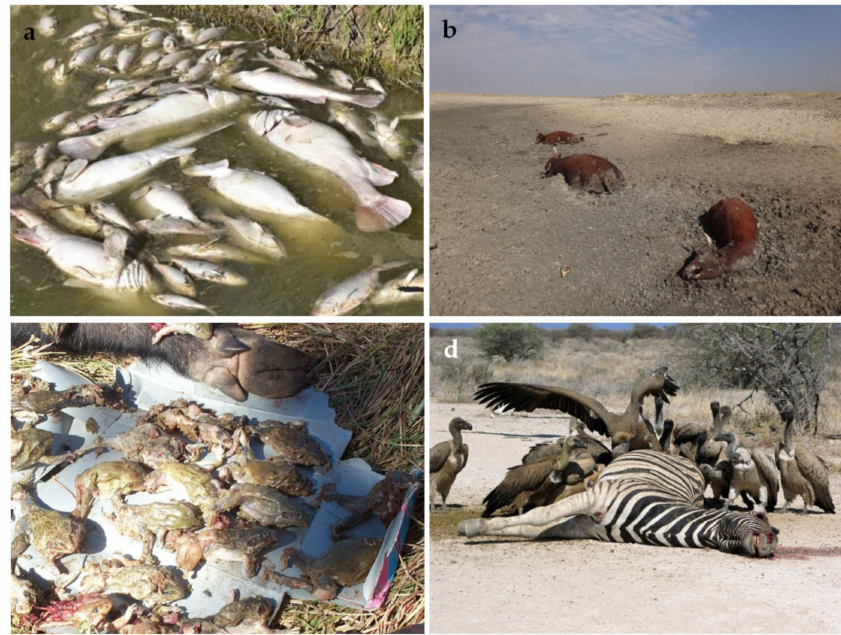
Figure 2. Examples of type 4 harms affecting animals as a result of food production: ( a ) Mass mortality of freshwater fish caused by eutrophication; ( b ) Free-ranging cattle ( Bos taurus ) that have perished during a drought influenced by climate change; ( c ) Mortality of frogs through predation by an invasive species, feral pigs ( Sus scrofa ), whose populations are derived from escaped agricultural animals; ( d ) mortality of a plains zebra ( Equus quagga ) from an infectious disease, anthrax, introduced via livestock. (Photos: Jonathon Howard, Jordan Hampton, Jim Mitchell, Wayne